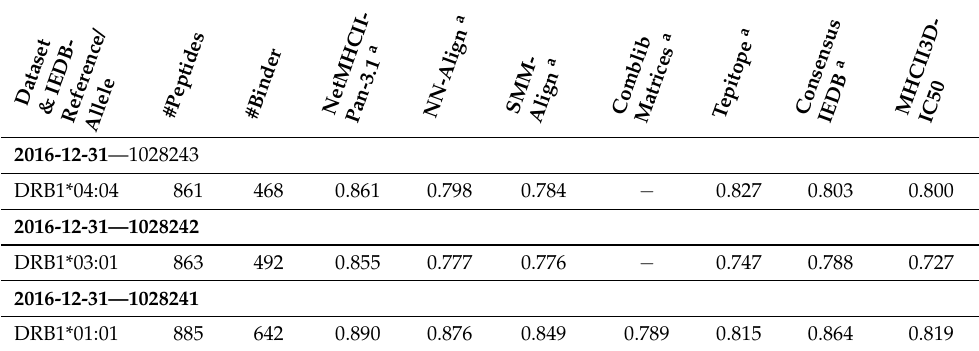
Table 1. Classification performance (AUC) in comparison with other methods on the IEDB weekly benchmarks. Numbers are shown for IEDB references providing IC 50 values and predictions are included for at least five of the pre-existing methods. a Result values are derived from the IEDB database (download version,